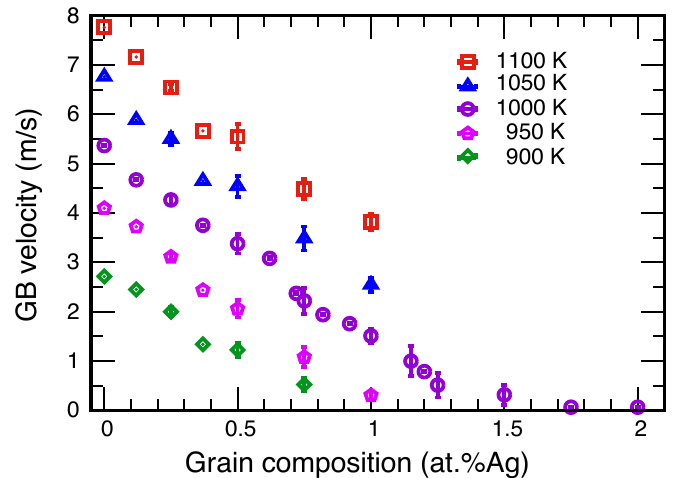
Figure 9. GB velocity as a function of temperature and alloy composition. The two zero-velocity points at 1000 K represent the GB arrest at concentrations above 1.5